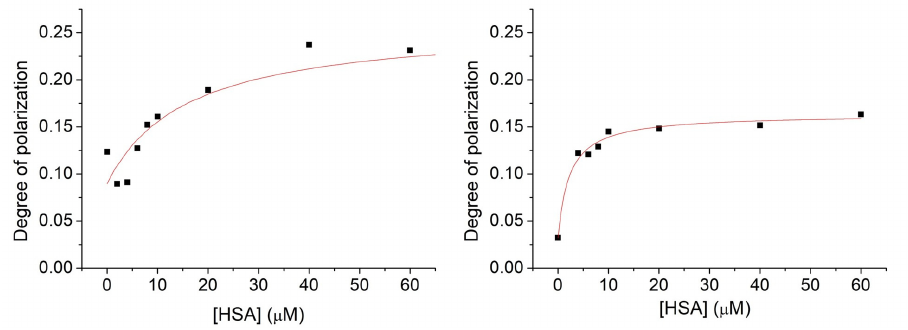
Figure 8. Fluorescence polarization spectra of compound 6 (1 µ M) in the presence of HSA with an increasing concentration within the range of 0–80 µ M. Experiments were performed in the absence ( left ) and in the presence of cavitand 2 ( right